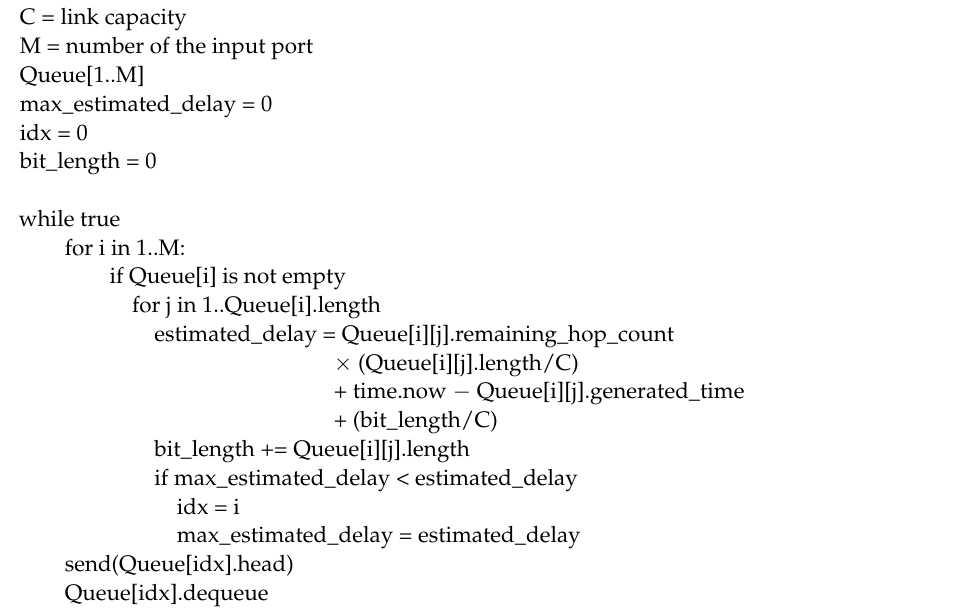
Algorithm 3. MED-HA in the output port